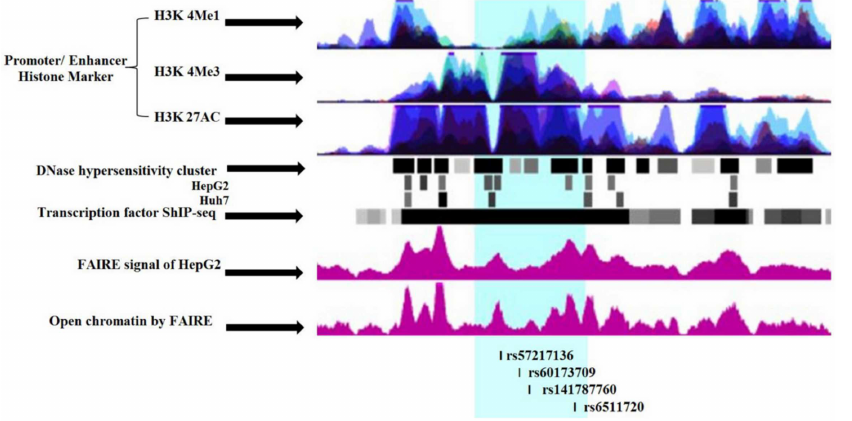
Fig 1. Genome-wide maps of chromatin state of LDLR intron-1. Schematicpresentationof the LDLR intron-1 chromatinstatus (https://genome-euro.ucsc.edu). The area of interest in intron-1 is highlightedin light-bluecolor. Promoter/ Enhancerhistonemarker of seven cell lines (GM12878, H1-hESC, HSMM, HUVEC, K562, NHEK, and NHLF). FAIRE: formaldehyde assisted isolationof